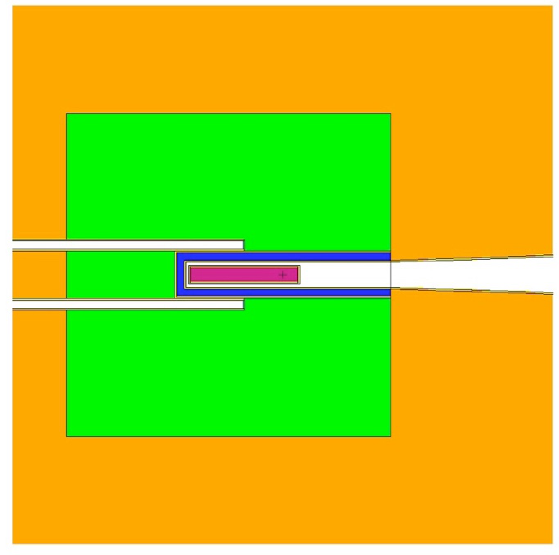
Fig. 2. 2-target geometry